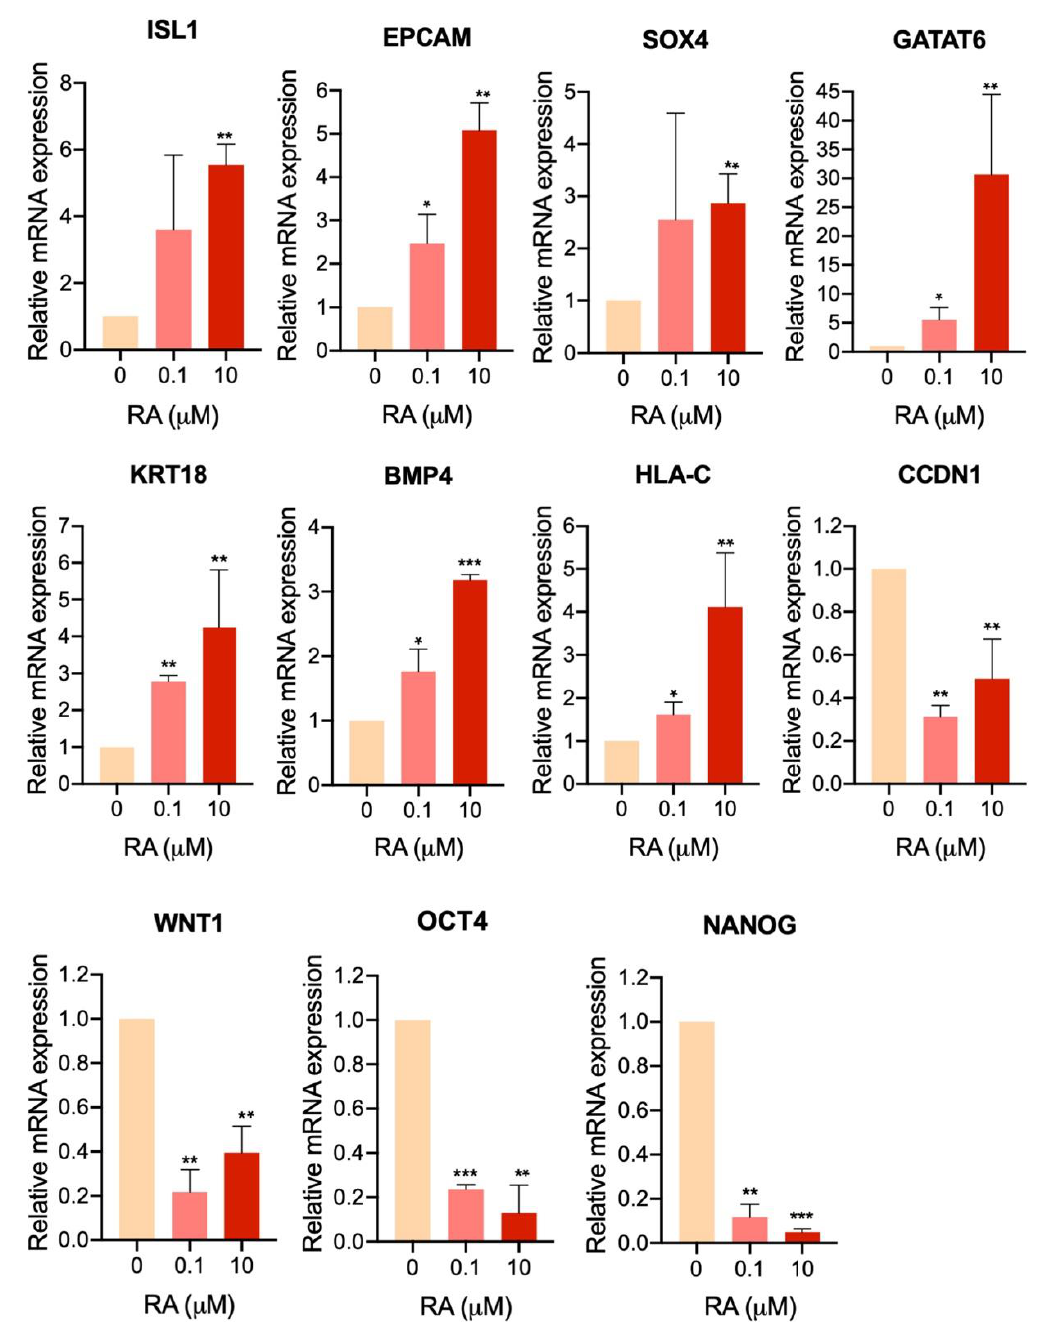
Figure 7. RNA-seq validation using quantitative PCR (qPCR). qPCR analysis for some differentially expressed genes (DEGs) in H9-hESC-derived EBs treated with 10 µM RA compared to those treated with 0.1 µM RA and untreated EBs at day 5 of differentiation. * p < 0.05, ** p < 0.01, *** p < 0.001.